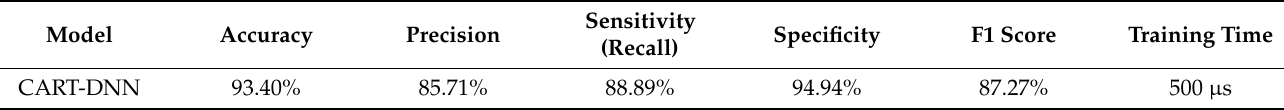
Table 5. Confusion matrix indicators: CART-DNN.